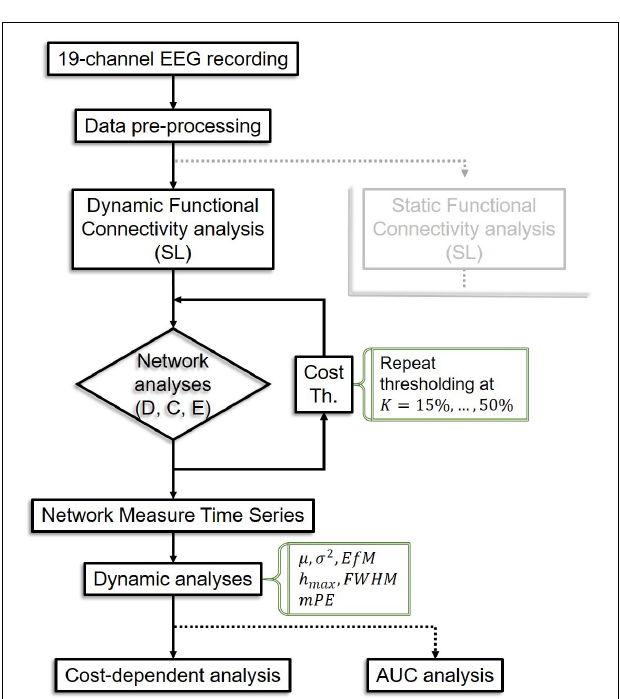
FIGURE 2 | Flowchart of the analysis pipeline. The analysis pipeline for static connectivity analysis is not shown as it is equivalent in most steps to the dynamic pipeline, except that only one connectivity matrix is acquired per subject, leading to only one value for each network measure instead of a time series, thus dynamic analyses are bypassed. SL, synchronization likelihood; D, connectivity strength; C, clustering coefficient; E, global efficiency; Th, thresholding; K , cost; AUC, area under the